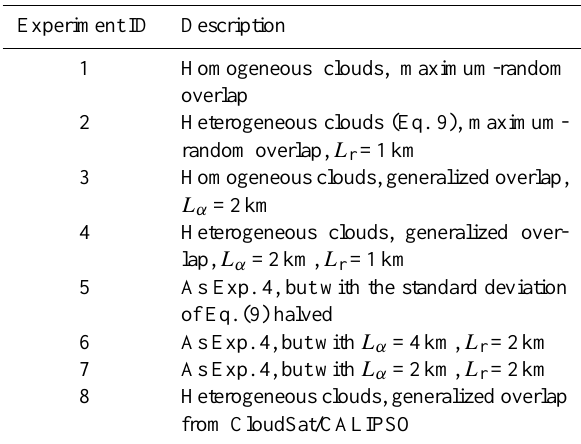
Table 2. List of experiments conducted with the GEOS-5 AGCM running two different cloud schemes to assess the effects of cloud heterogeneity and overlap on the cloud radiative